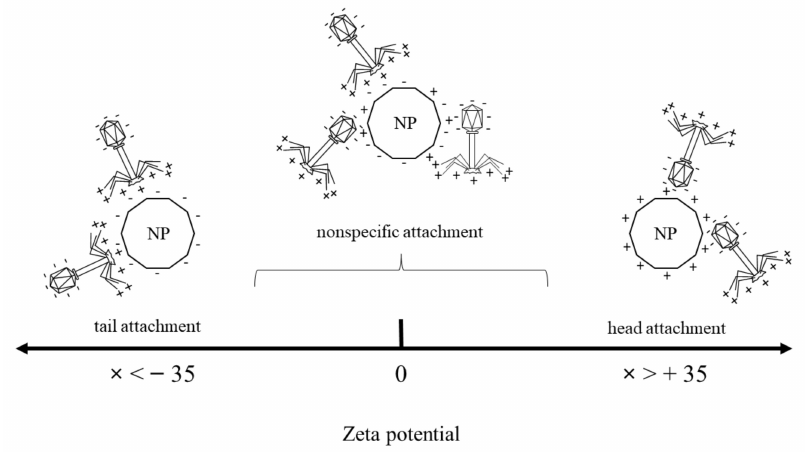
Figure 6. Proposed graphic explanation of the phenomenon of the electrostatic attachment of the phage T4-like and the tested nanoparticles.